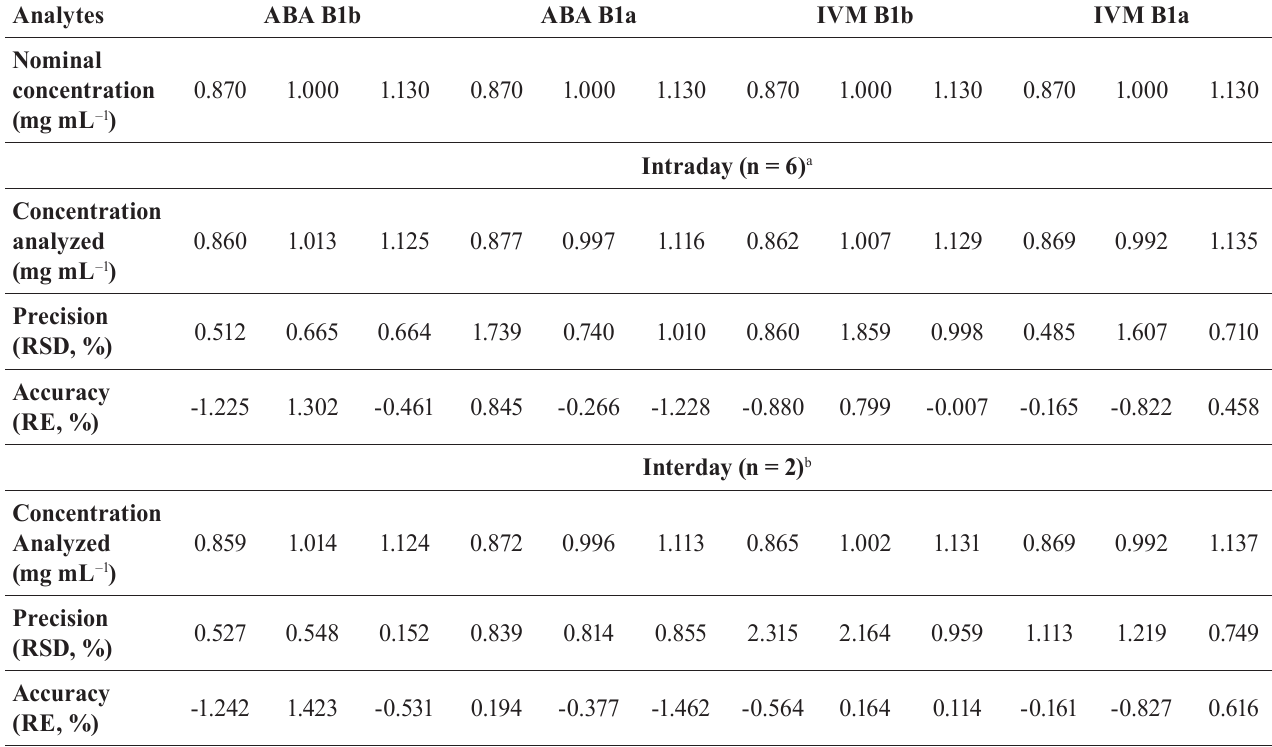
TABLE VI - Medium values of the precision and accuracy for ABA B1b and B1a, IVM B1b and B1a analysis